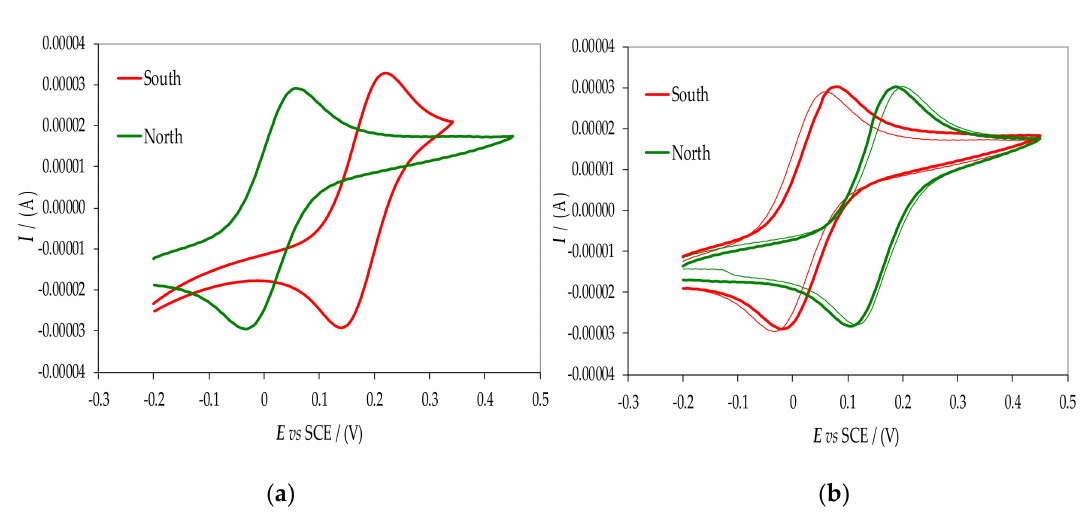
Figure 12. CV patterns recorded at 0.05 V s –1 for the Fe(III) / Fe(II) achiral couple on hybrid ITO | oligo-( R )-Naph 2 T 4 ( a ) and oligo-( S )- Naph 2 T 4 ( b ) electrodes as a function of the applied magnetic field orientation (red line vs green line for south and north configuration, respectively). In the plot on the right, reproducibility tests are also